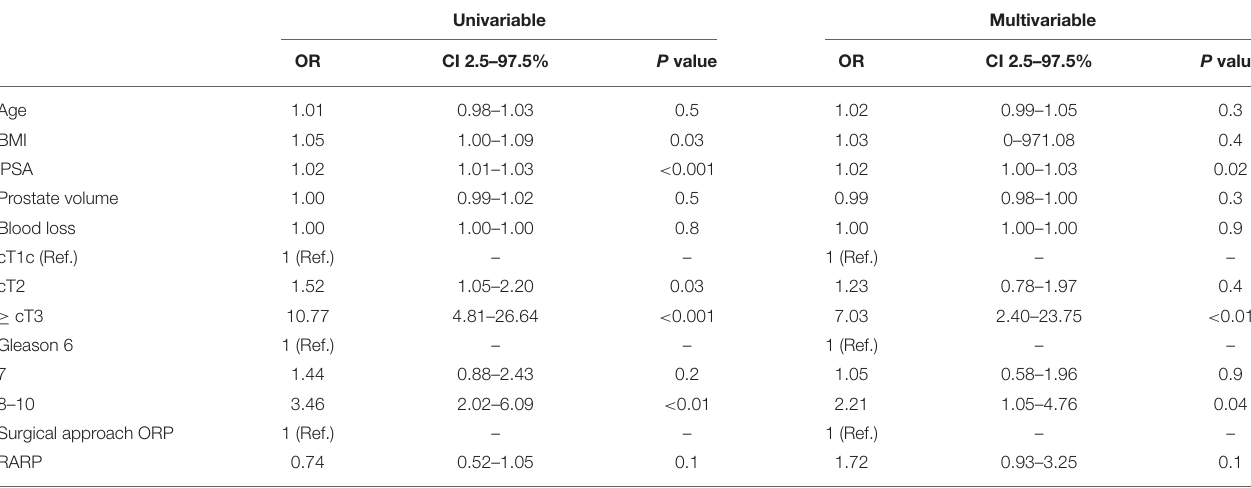
TABLE 6 | Univariable and multivariable logistic regression model predicting Positive Surgical Margin